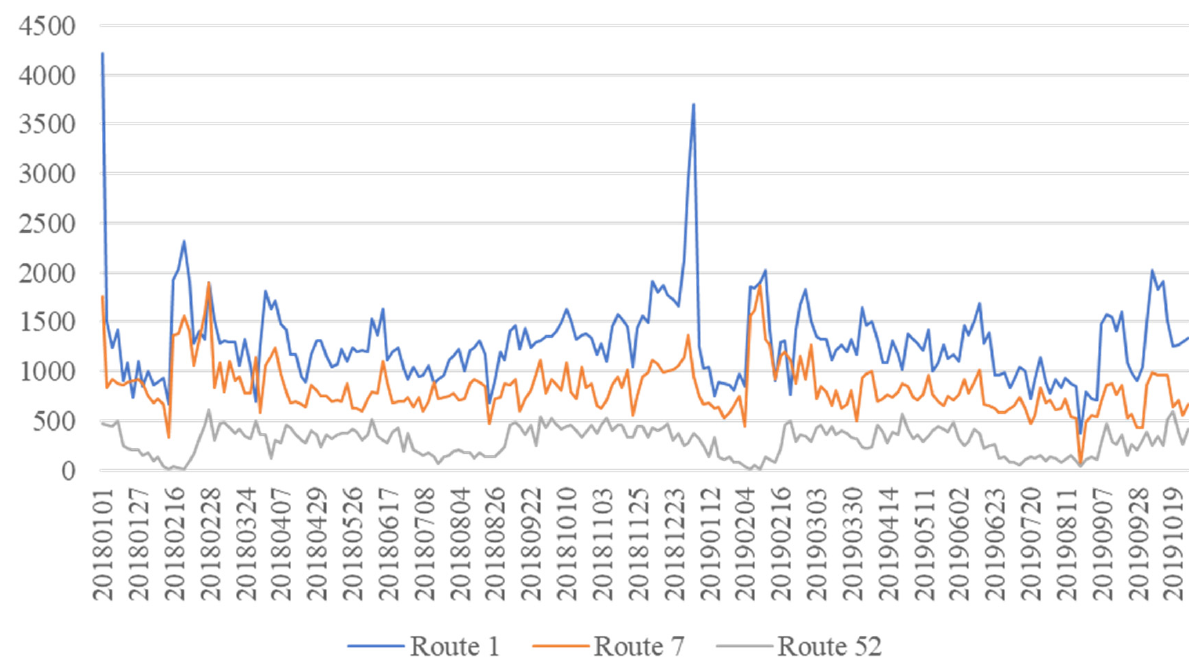
Figure 5. The number of passengers per day for the top three routes on holidays.